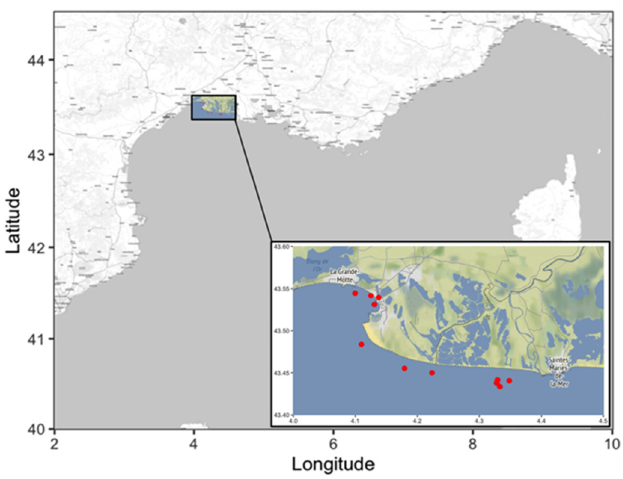
Fig. 1. Sampling area in the Grau du Roi site in the Gulf of Lion.